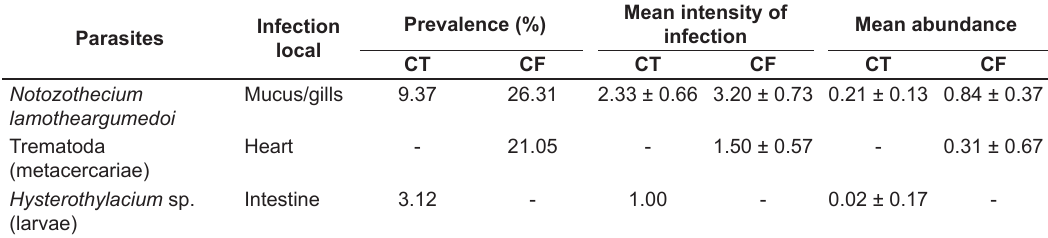
CT = control area; CF = cage farm